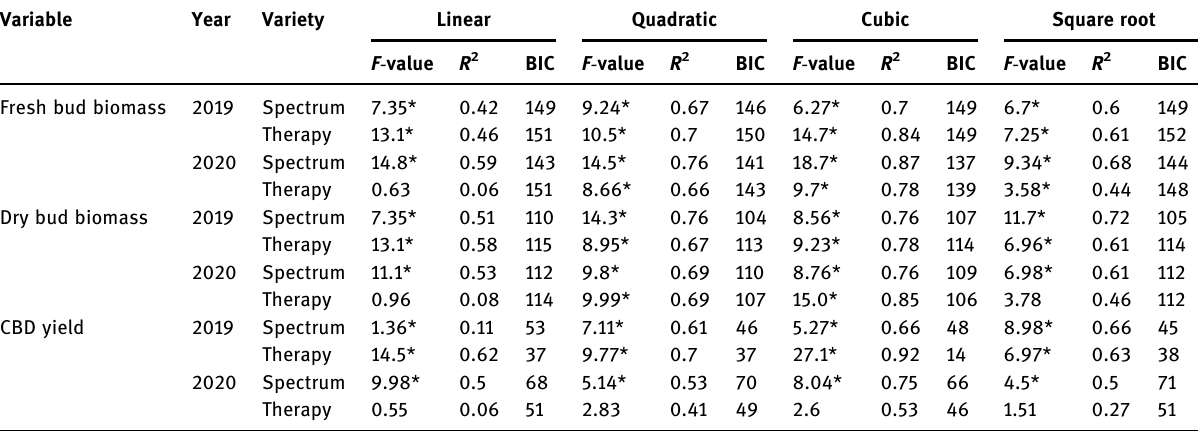
Table 2: The F - values, coe ffi cients of determination ( R 2 ) , and BIC for models describing relationships between N fertilizer rate and fresh bud yield, dry bud yield, and CBD yield using centered independent variables Variable